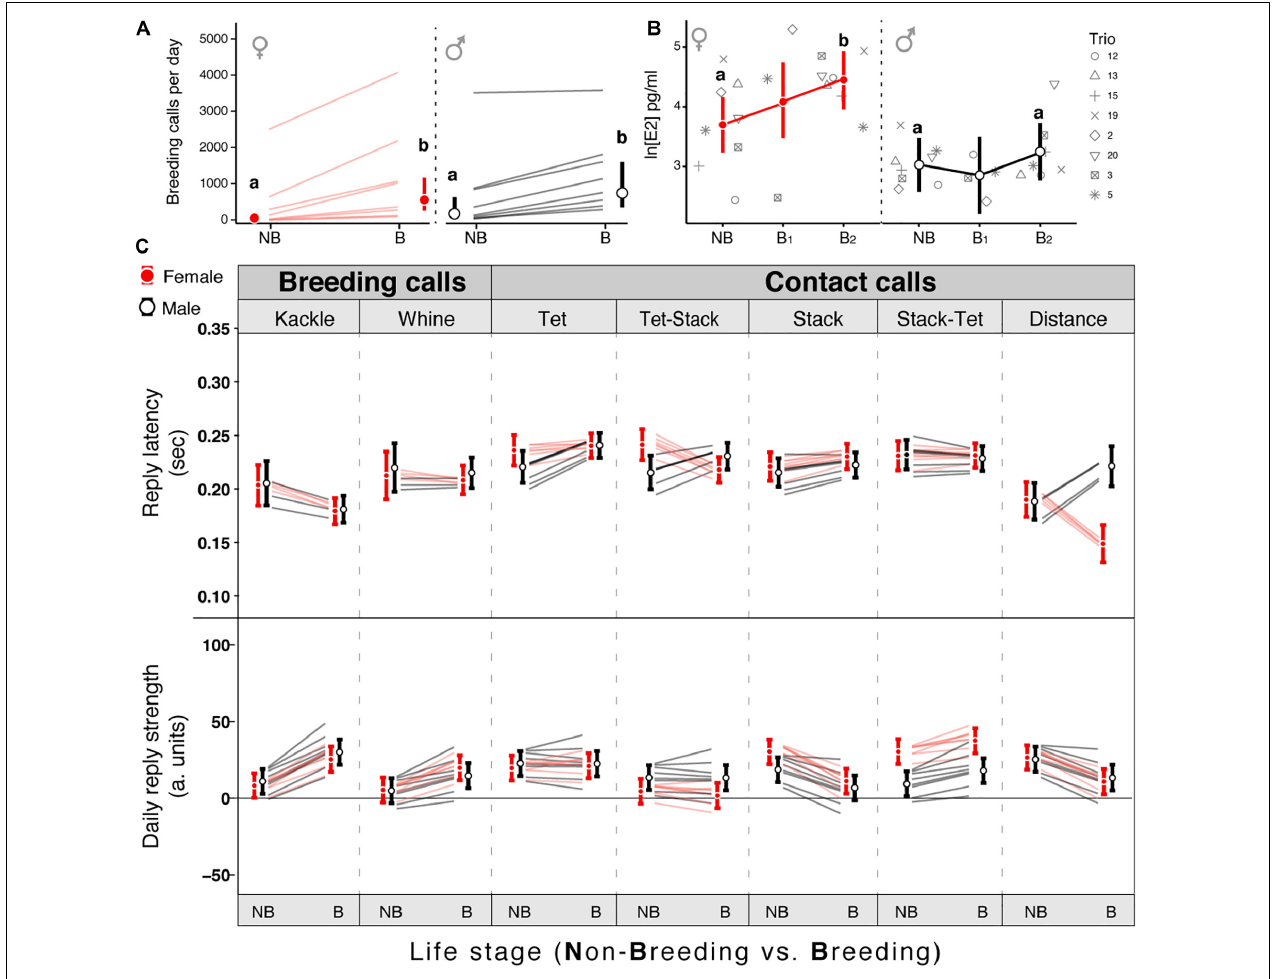
FIGURE 2 | Onset of breeding conditions affects the call-based vocal interactions. (A) Number of breeding calls elicited per morning by males (black) and by females (red) during non-breeding (NB) and breeding (B) conditions. (B) Change in estrogen (E2) levels of males and females from NB to B (B 1 : 24 h after the breeding onset; B 2 : 24 h after last experimental day). (C) Breeding induced change in reply latency (top) and reply strength (bottom) of males (black) and females (red) for seven different call interactions. Circles reflect the mean estimate from the model, vertical bars the 95% credible intervals (CrI) and each line represents the change within an individual bird. In panels (A,B) Different letters indicate a posterior probability of difference higher than 95%. For panel (C) a probability of difference higher than 95% can be assumed if the estimates of a group do not overlap the CrI of the other